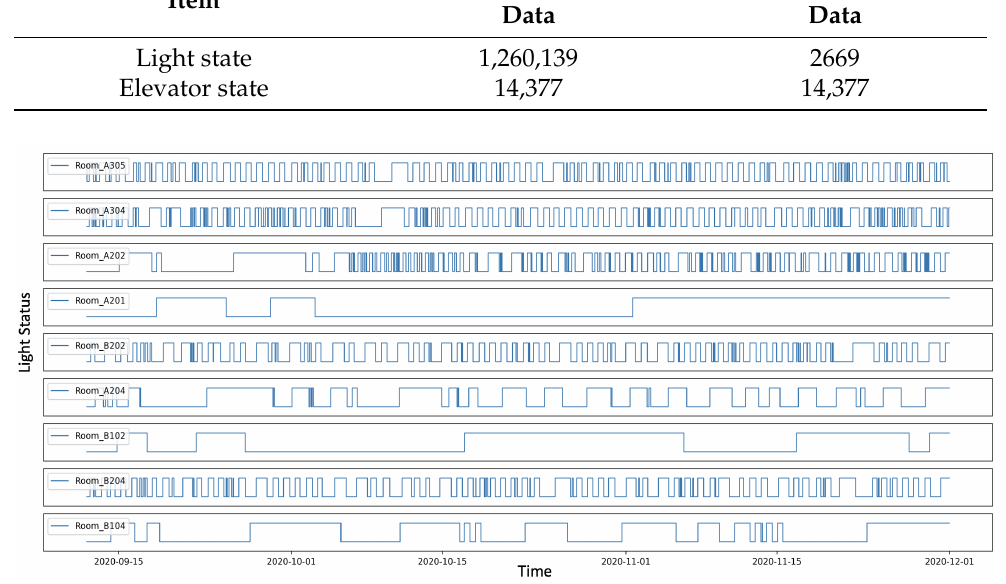
Figure 11. The real examples of the monitored light states in several